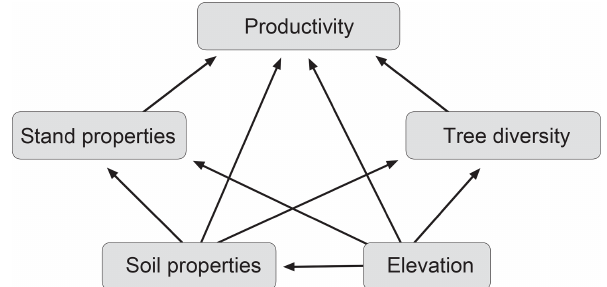
Figure 1. Conceptual model of plausible interaction pathways be- tween environment (elevation, soil) and forest structure as drivers of productivity. Arrows drawn from the two boxes “stand proper- ties” and “soil properties” indicate that pathways from the respec- tive variables (forest stand properties: wood specific gravity, stem density, leaf area index (LAI); soil properties: first two principal component analysis (PCA) axes) were included in the